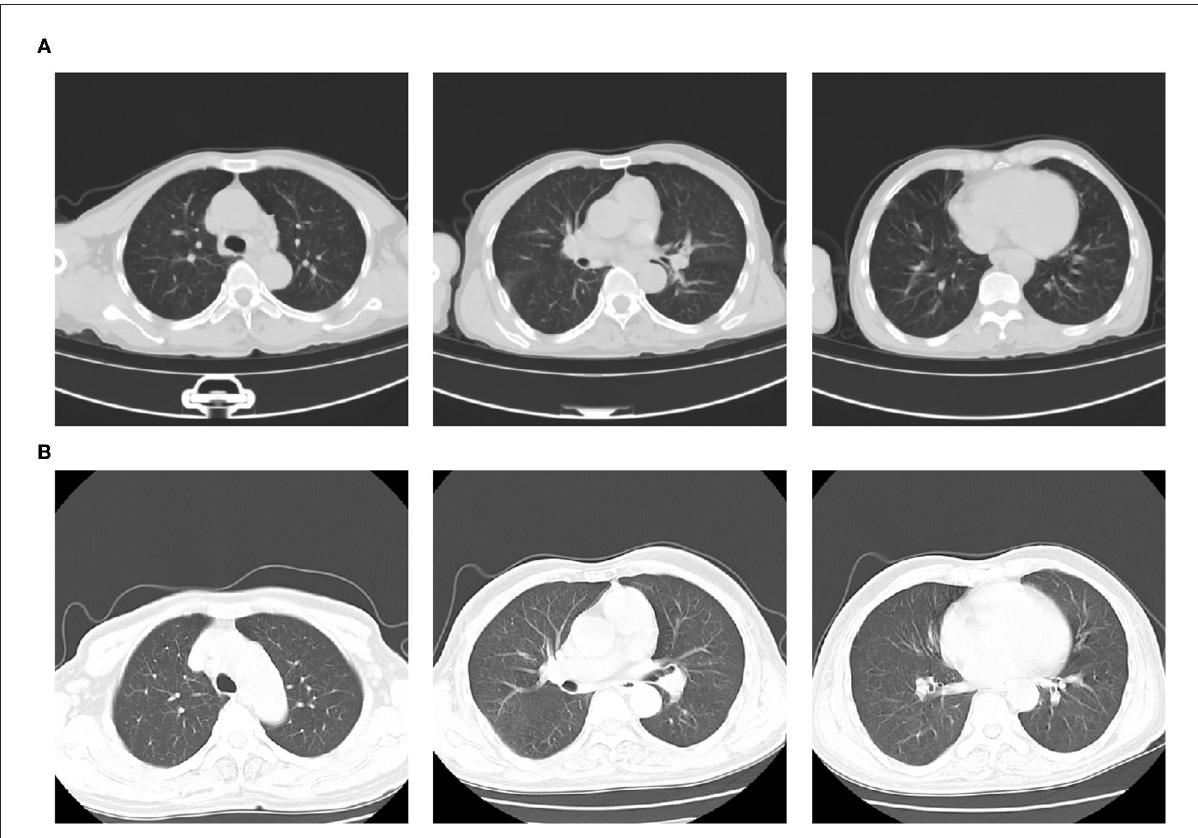
FIGURE1 Computed tomography (CT) on admission showing chronic bronchitis with bilateral lung infection (A) ; CT presentation on day 14 of hospitalization (day 3 of meropenem administration): No obvious lesions in both lungs. However, multiple enlarged lymph nodes are seen in the mediastinum and bilateral axillae (B)